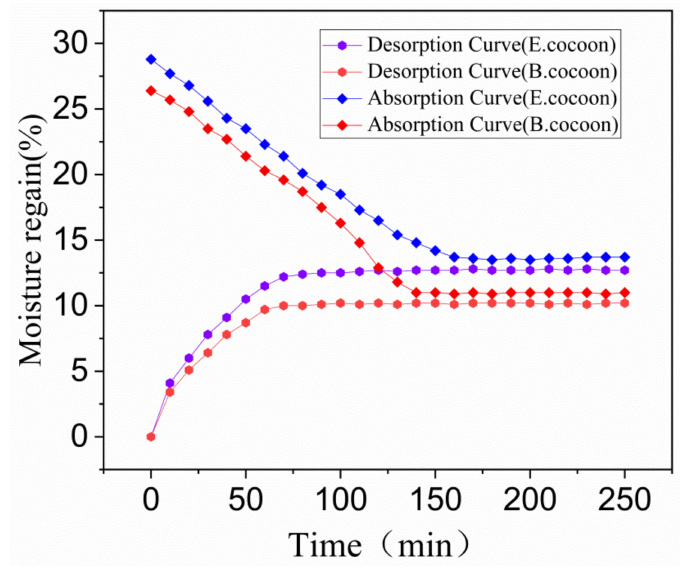
Figure 10. Moisture absorption and desorption curves of E and B